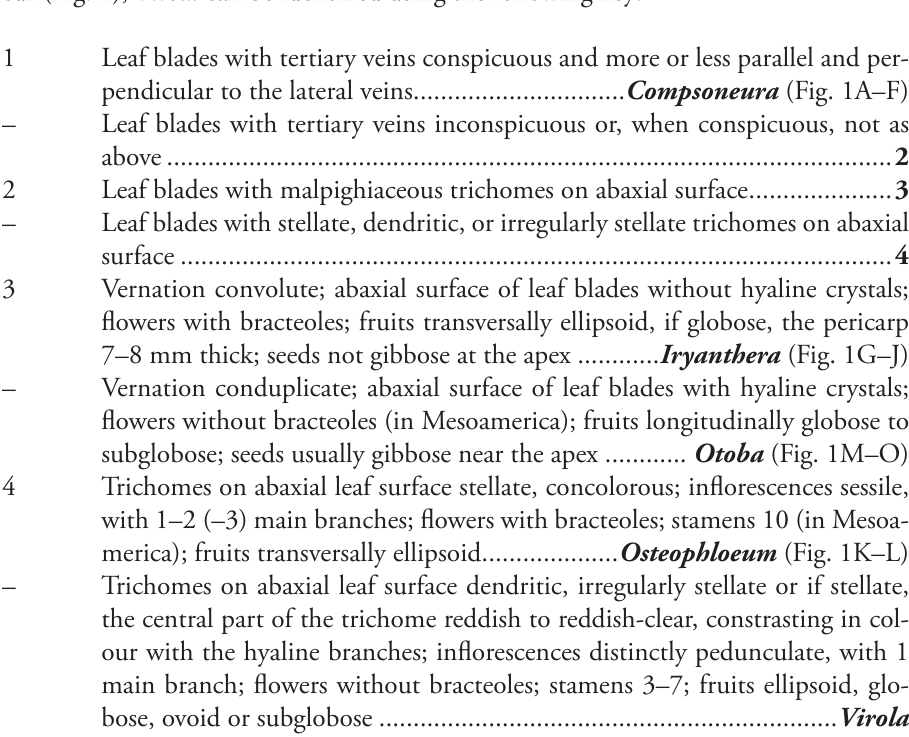
Figure 1. Genera of Myristicaceae present in Mesoamerica A–C Compsoneura sect. Compsoneura ( C. ex- celsa ) D–F Compsoneura sect. Hadrocarpa ( C. capitellata ) G–J Iryanthera ( G–I Iryanthera spp; J I. megisto- carpa ) K–L Osteophloeum platyspermum M–O Otoba novogranatensis . Photos by Reinaldo Aguilar ( A–C, M–O ), Benjamin Chambi ( E ), Jason D. Wells ( D, F from http://atrium.andesamazon.org/); Robin Foster ( G–I, K from https://plantidtools.fieldmuseum.org/en/nlp); Alwyn H. Gentry ( J from http://www.tropi- cos.org); and David A. Neill ( L